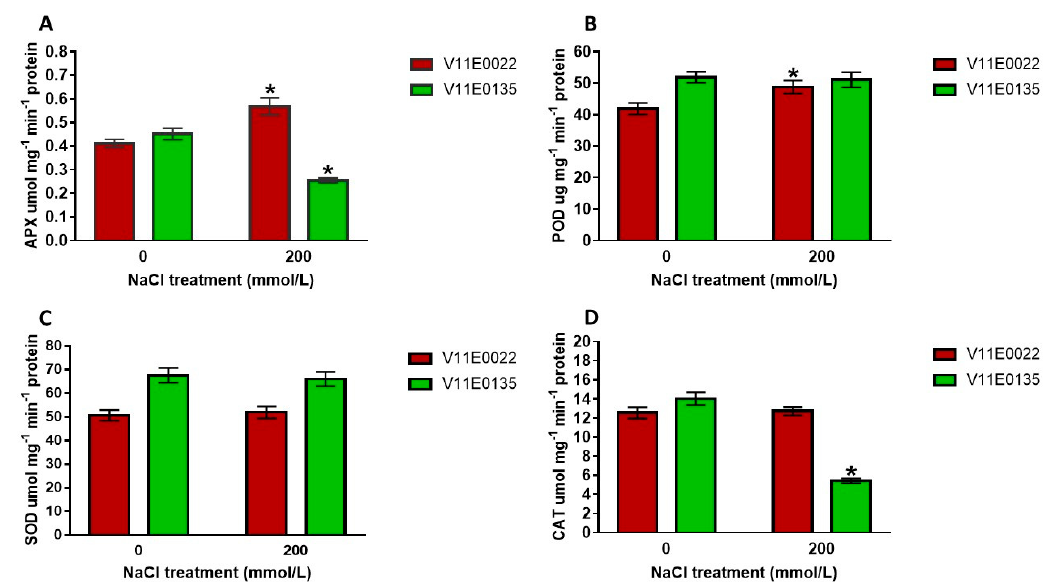
Figure 5. Effect of salt stress on antioxidant enzymes. ( A ) APX activity, ( B ) POD activity, ( C ) SOD activity, and ( D ) CAT activity in water dropwort cultivars. Bars with the asterisks (*) indicate the significant difference ( p < 0.05) between the control and its respective treated samples. Values are means ± SD.